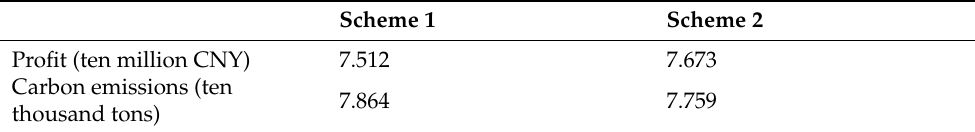
Figure 6. Comparison diagram of recovery network between scheme 1 and scheme 2. Table 13. Total profit and carbon emissions of scheme 1 and scheme